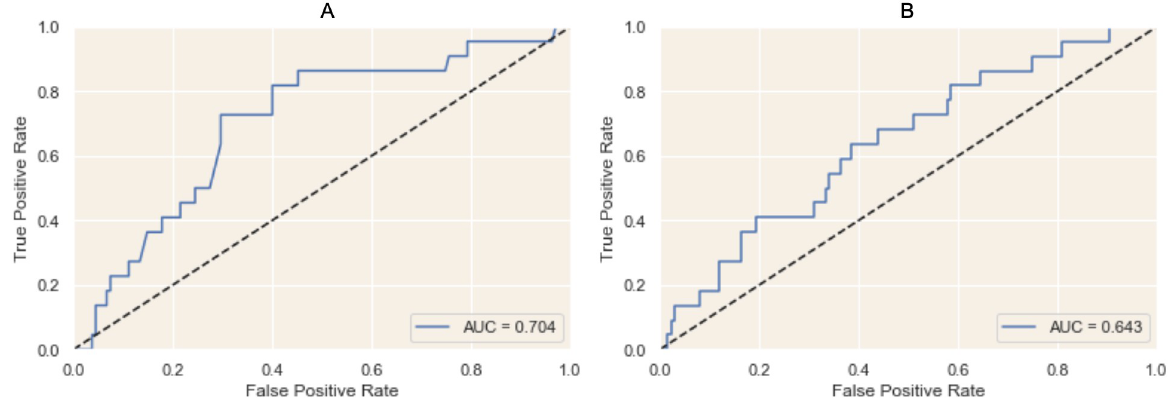
Fig 3. Receiver operating characteristic for predictive frailty on in-clinic walk tests. This figure represents the ability of A) at-home 6MWT data to predict in-clinic 6MWT and B) passive activity data to predict in-clinic 6MWT using a logistic regression model. The AUC of A) is 0.704 while the AUC of B) is 0.643 suggesting that passive data is nearly as accurate as an at-home 6MWT in predicting frailty as measured by an in- clinic 6MWT.